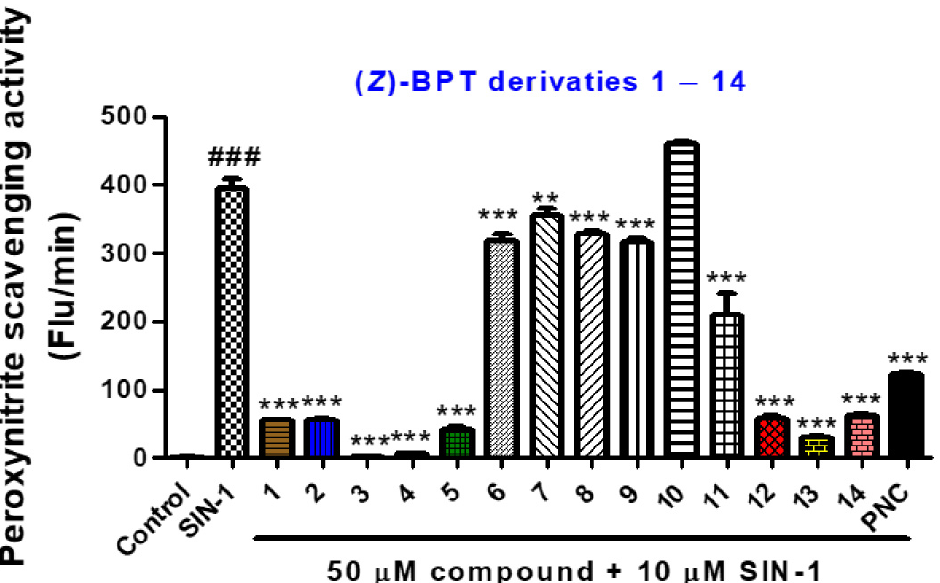
Figure 12. Peroxynitrite scavenging effects of ( Z )-BPT derivatives 1 – 14 using DHR123 (an ROS indicator) and SIN-1 (RNS/ROS generator). Penicillamine (PNC) was used as a positive reference material. PNC and test samples were used at a concentration of 50 µ M and SIN-1 was used at a concentration of 10 µ M. ### p < 0.001 for SIN-1-treated controls vs. non-treated controls; *** p < 0.001 and ** p < 0.01 for compound-treated groups vs. SIN-1-treated controls.